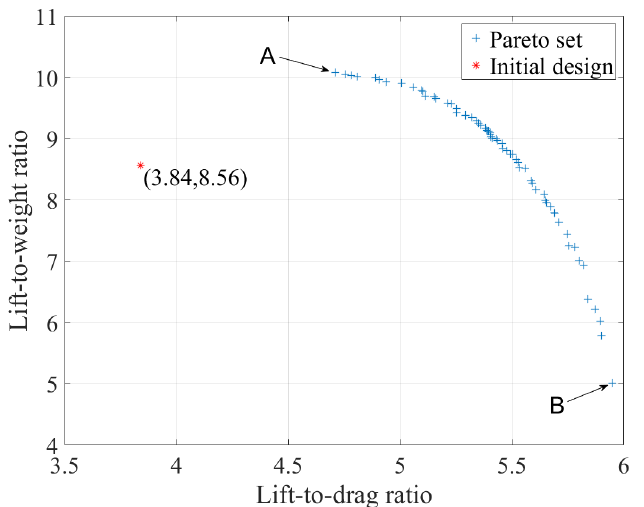
Figure 16. Pareto-optimal solution